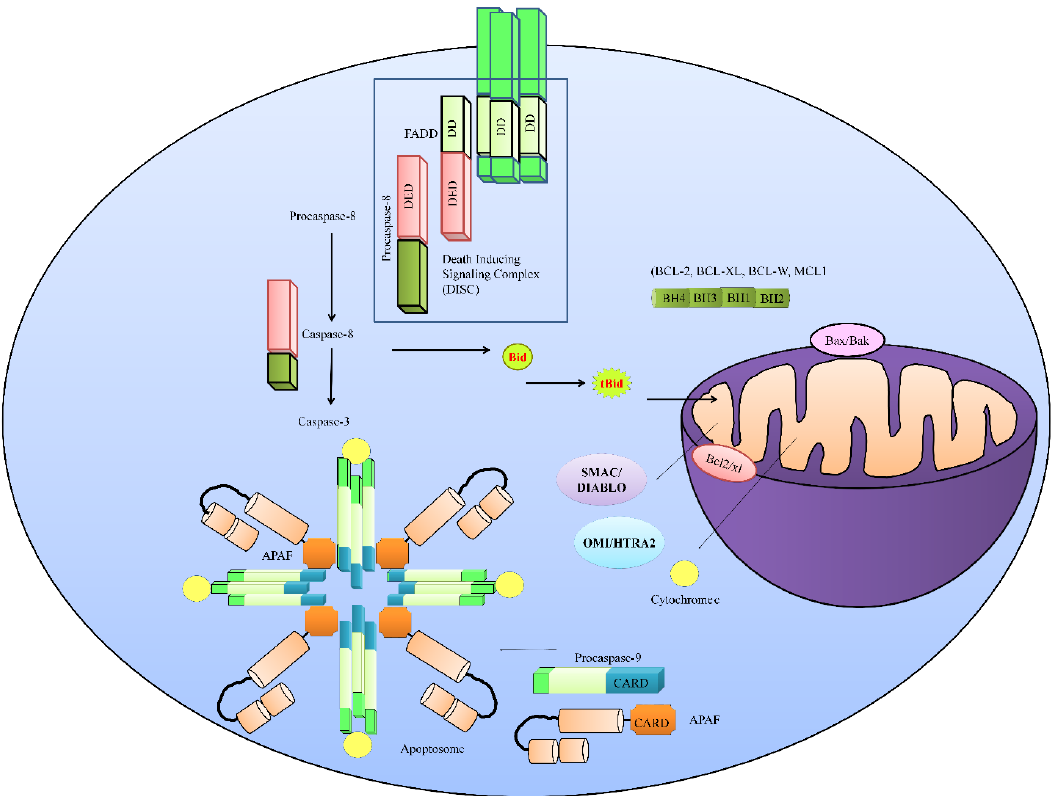
Figure 1. TRAIL (TNF-related apoptosis-inducing ligand)-mediated signaling. TRAIL transduces